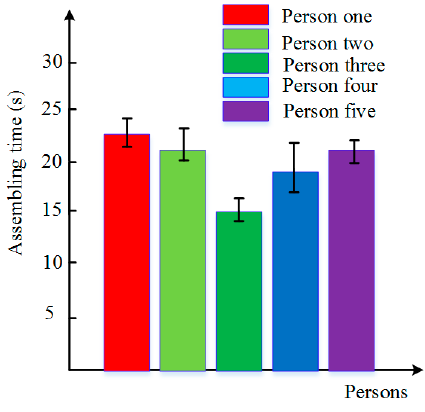
Figure 24. Assembling time for human beings.